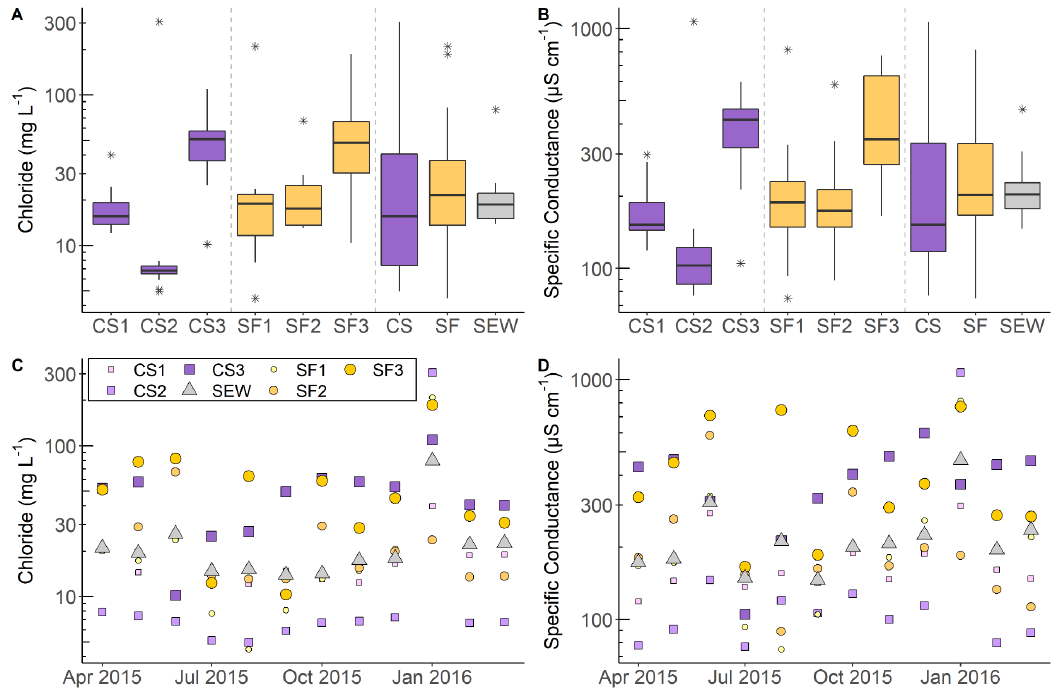
Figure 3. Chloride ( A , C ) and specific conductance ( B , D ) values from watersheds grouped by wastewater treatment approach and increasing septic system density. Pooled data are shown for each group as CS = conventional septic; SF = sand filter; SEW = sewer. The asterisks (*) denote outliers.